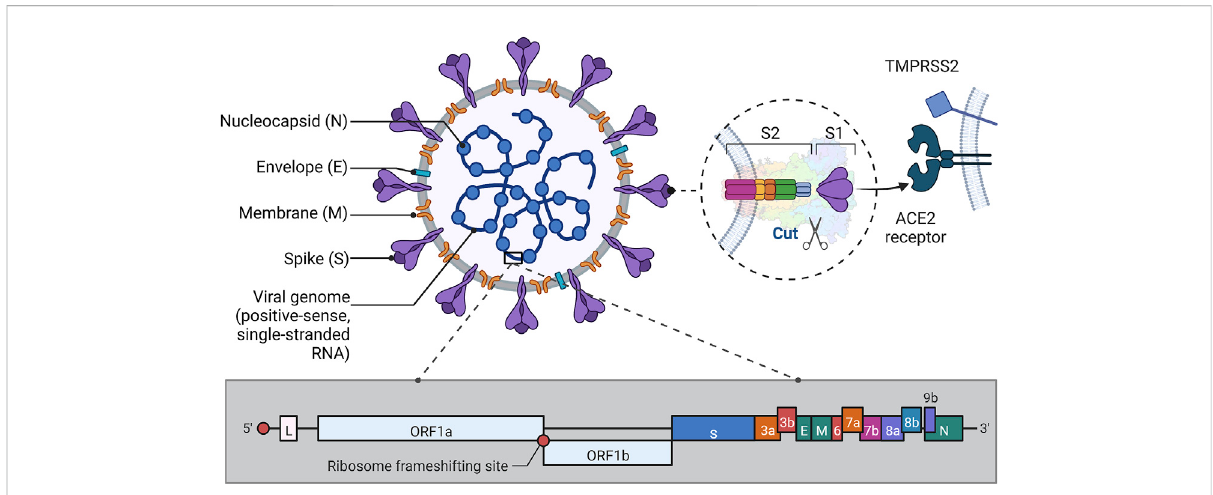
FIGURE 1 Structure of SARS-CoV-2. Illustrative scheme: This fi gure shows the approximate protein structure of SARS-CoV-2 and the gene fragment of RNA, in addition to depicting the way S1 binds to the ACE2 receptor to invade the organism. As can be seen in the fi gure, except for the N protein whichiswrappedaroundthenucleicacid,theE,M,andSproteinsareanchored totheenvelope,eachinitsway.Amongthem,theSproteinconsists of two subunits, S1 and S2. S1 protein has a receptor binding domain (RBD) on it that binds to ACE2 on the host cell. S2 protein has a more complex structure and its role is to fuse the virus to the host cell membrane. In the pre-fusion conformation, the S1 and S2 subunits remain non- covalentlybound.Whenthenovelcoronaviruswantstoenterthehostcell,theSproteinshiftsfromtheclosedtotheopenstate,thusmediatingentry